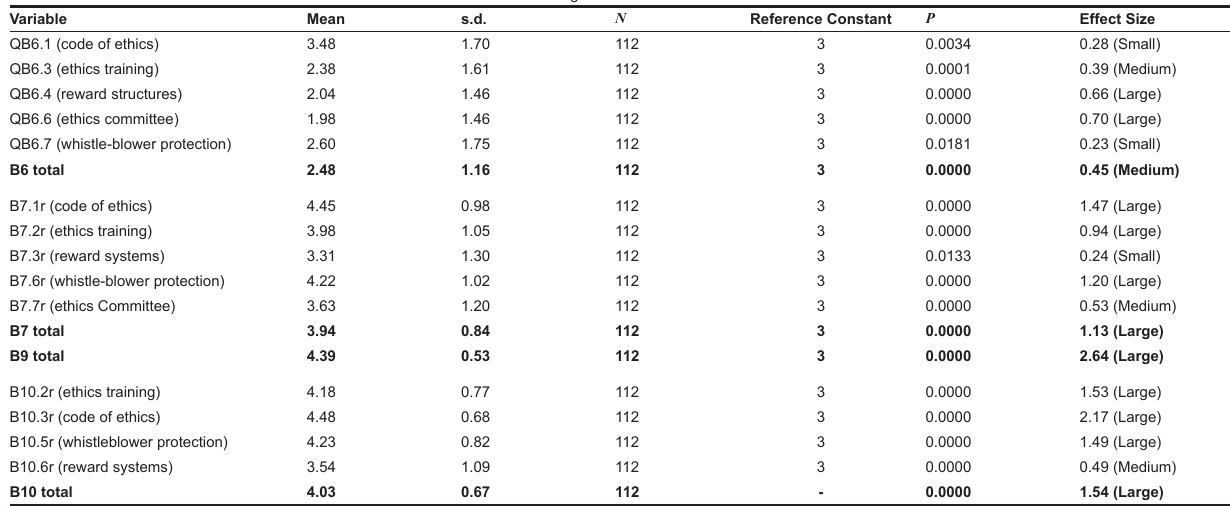
TABLE 13 Test of means against constant reference